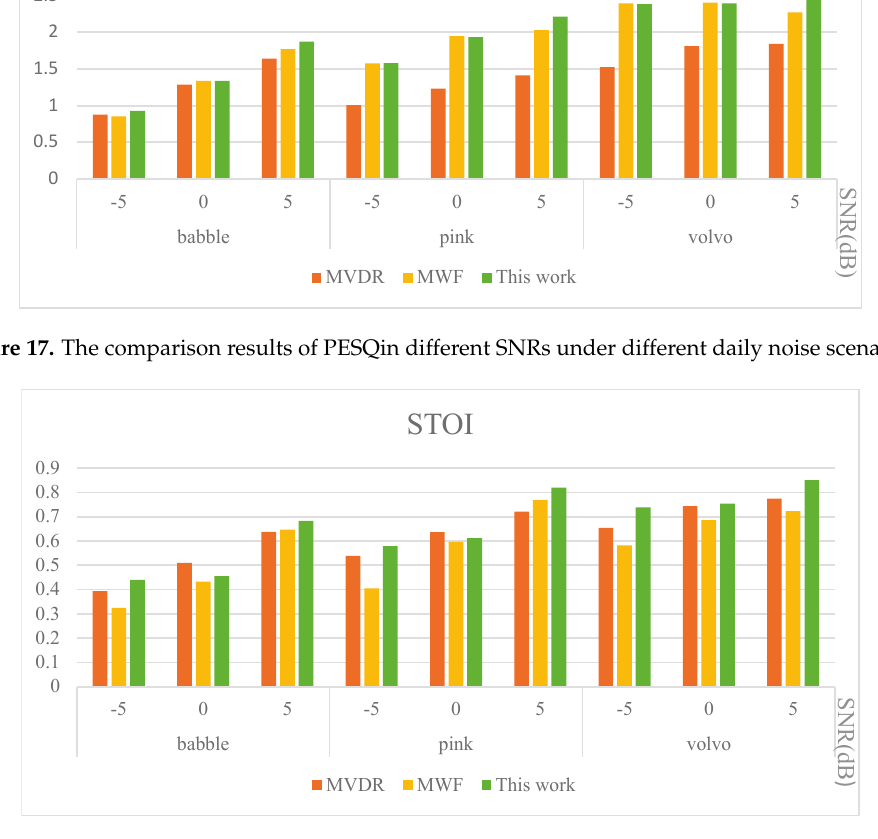
Figure 18. The comparison results of Short-Time Objective Intelligibility (STOI) in different SNRs under different daily noise